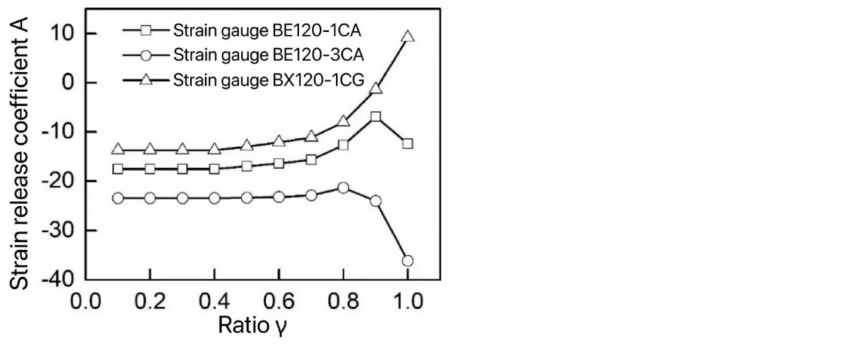
Figure 8. Variation curve of strain release coefficient A with ratio γ of different strain gauges.